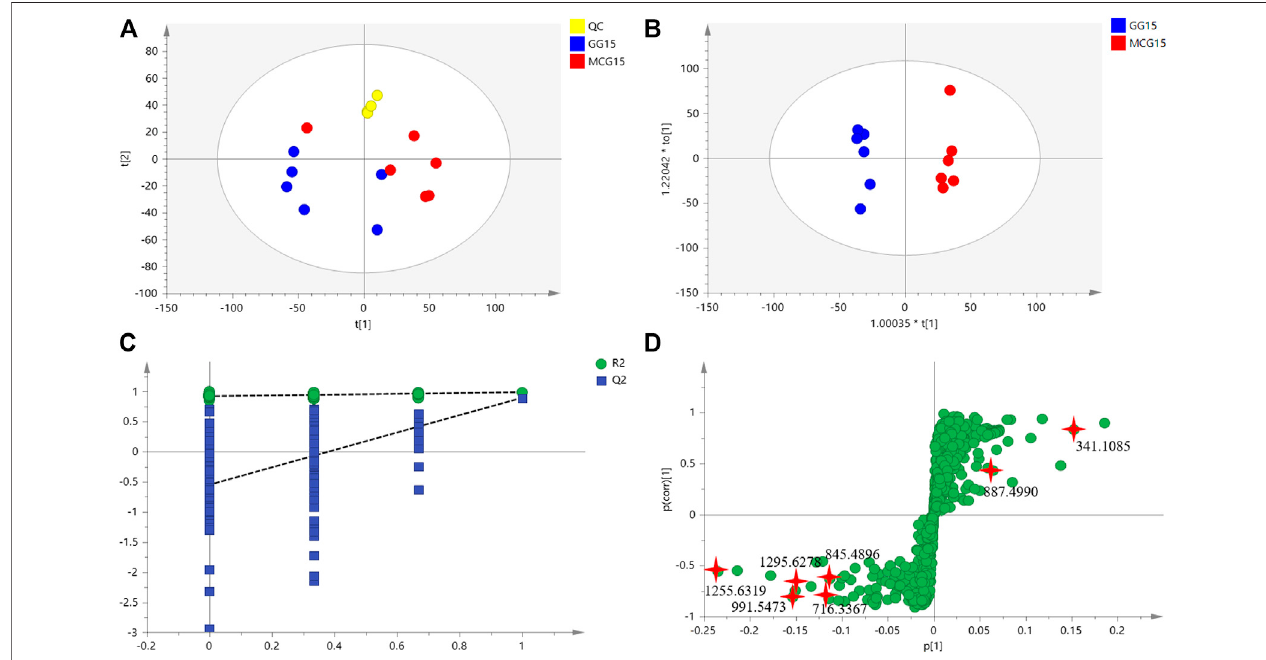
FIGURE1| TheuntargetedmetabolomicsanalysisbasedonmultivariatestatisticalanalysisofMCGandGG. (A) :scoreplotofPCA; (B) scoreplotofOPLS-DA; (C) validation plots obtained from 200 permutation tests for the OPLS-DA models; (D) score plot of S-Plot.